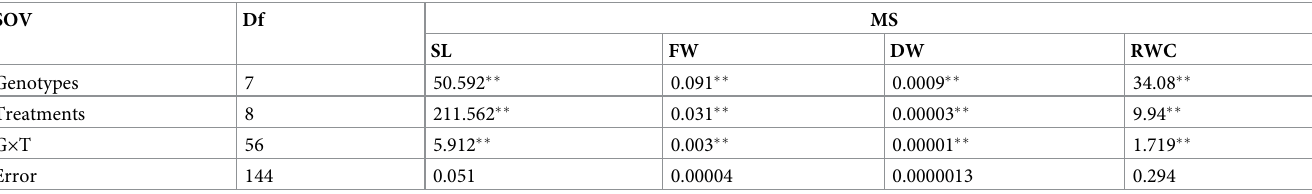
Table 2. Mean sum of squares for morphological parameters of eight mung bean genotypes grown under Cd and pretreatments of GA 3 , SA and proline prior to Cd. SOV Df MS SL FW